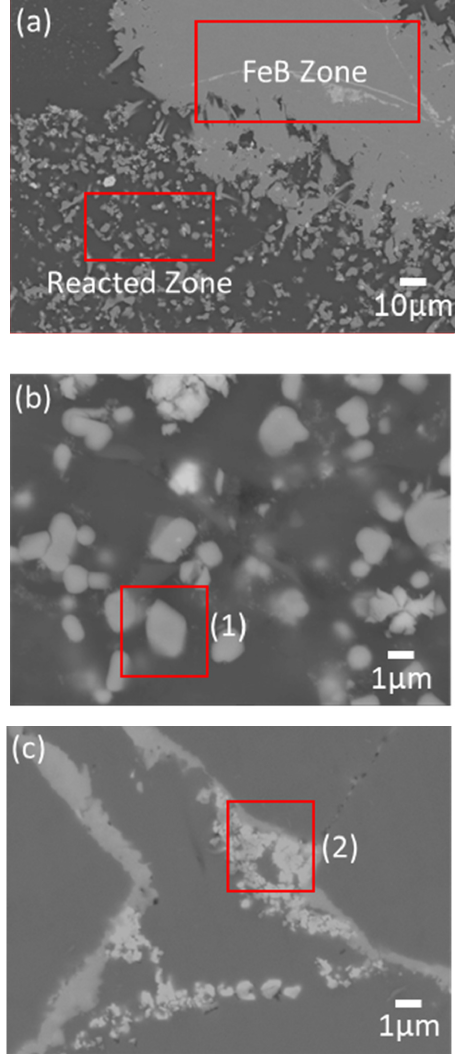
Figure 8. Overall microstructures of the ( a ) reacted zone (×500 magnification), FeB zone, and enlarged microstructures of the ( b ) reacted zone and ( c ) FeB zone (×5000 magnification).